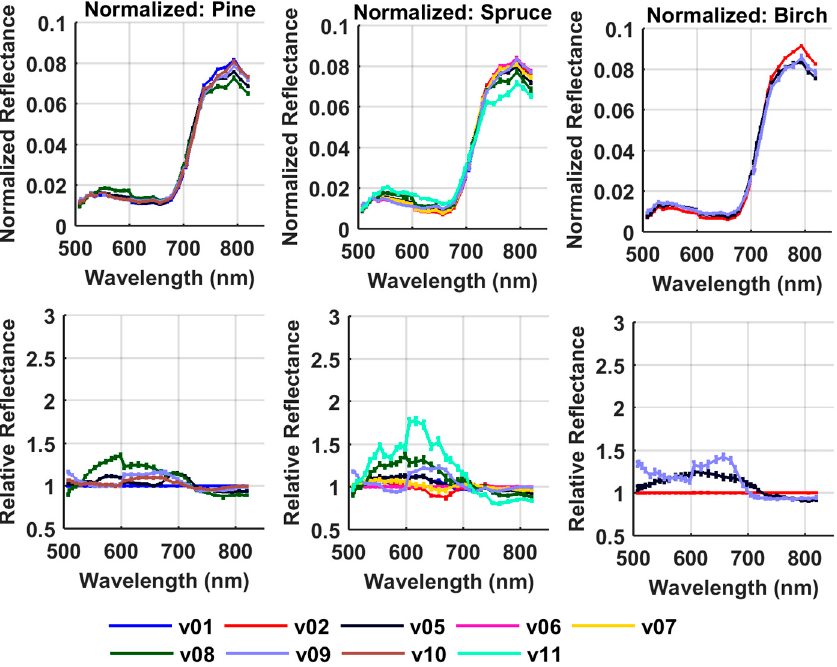
Figure 10. Normalized mean spectra of different species at different test sites (top row) and their relative differences (bottom row). In the relative differences, Pine spectra have been normalized to test site v01, Spruce to v06 and Birch to v02. The error bars present the standard error.